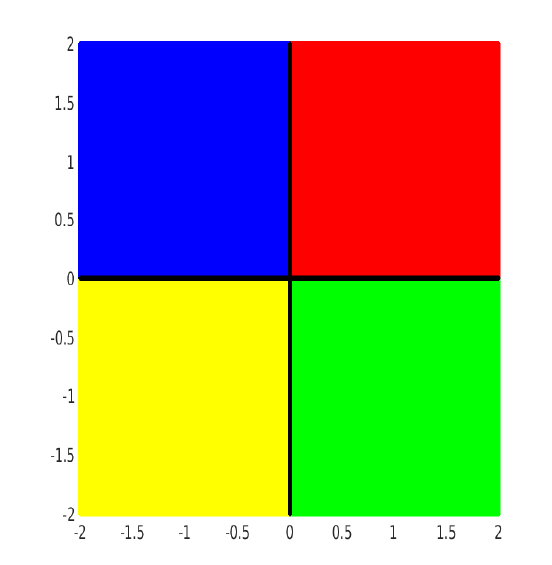
Figure 5. Dynamical plane of method (2) with basins of attraction for Example 7.